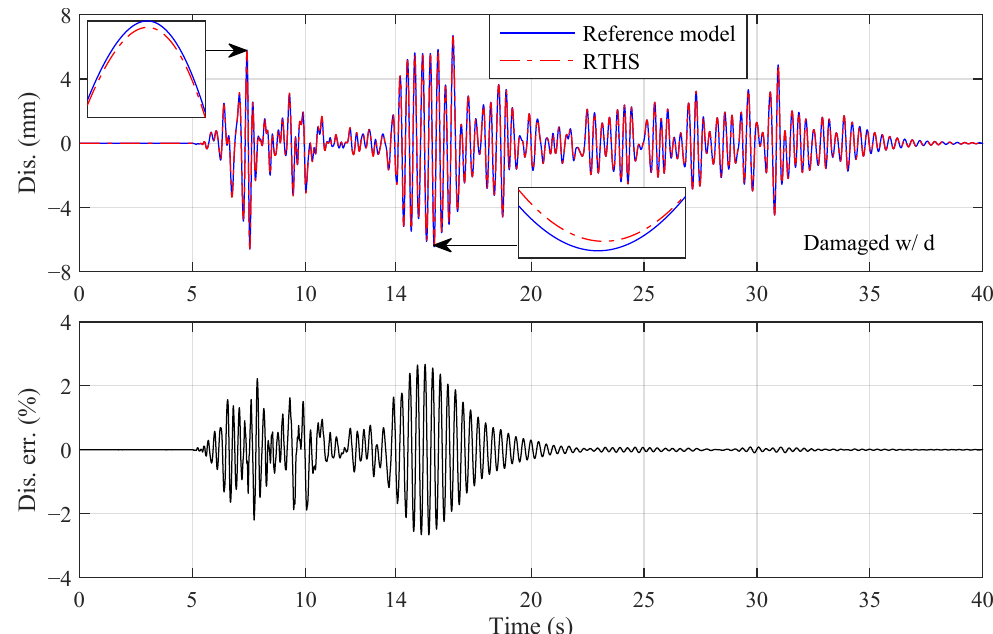
Figure 16. Third-floor displacement responses of Damaged w/ d (El Centro earthquake, Case 4, perturbed plant).